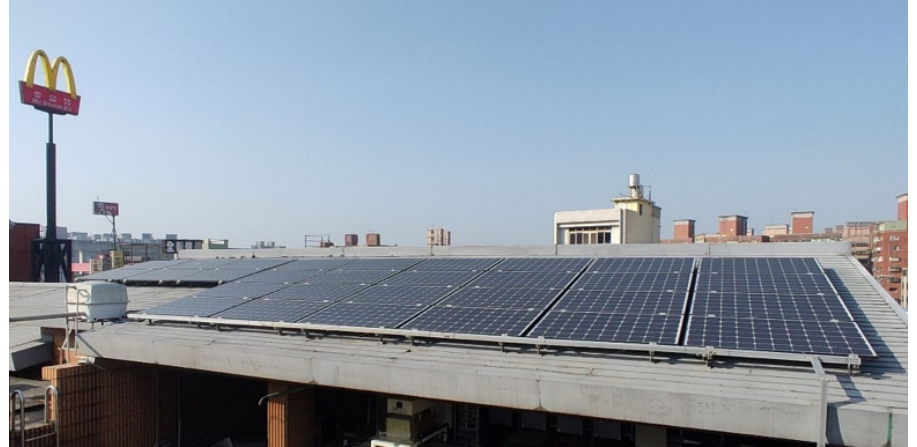
Figure 2. Rooftop solar PV with 30 solar panels and 10 kW capacity in Yangmei District, Taiwan.